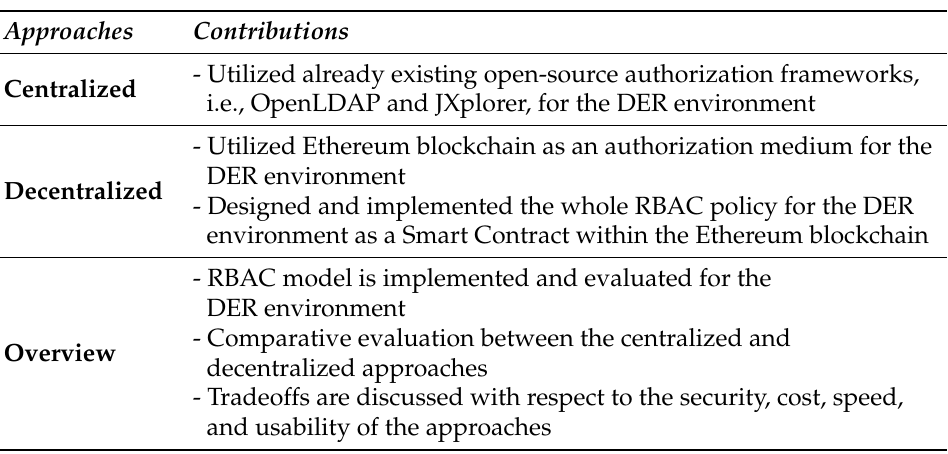
Table 1. Summary of the main